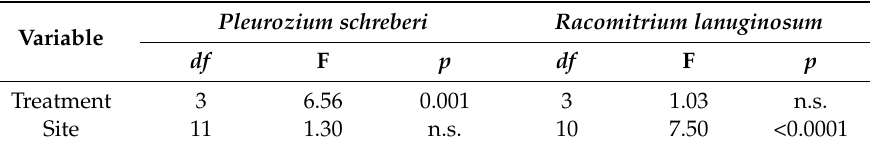
Figure 1. Fv/Fm before the experiment for different altitudinal sites and their areas in: ( A ) P. schreberi and ( B ) R. lanuginosum . For statistical significance, see Table 1. Table 2. Results of one-way ANOVA testing responses in Fv/Fm after four different short-term temperature treatments ex situ among 12 and 11 populations of P. schreberi and R. lanuginosum , respectively, originating from different altitude sites. n.s. = no significant difference.